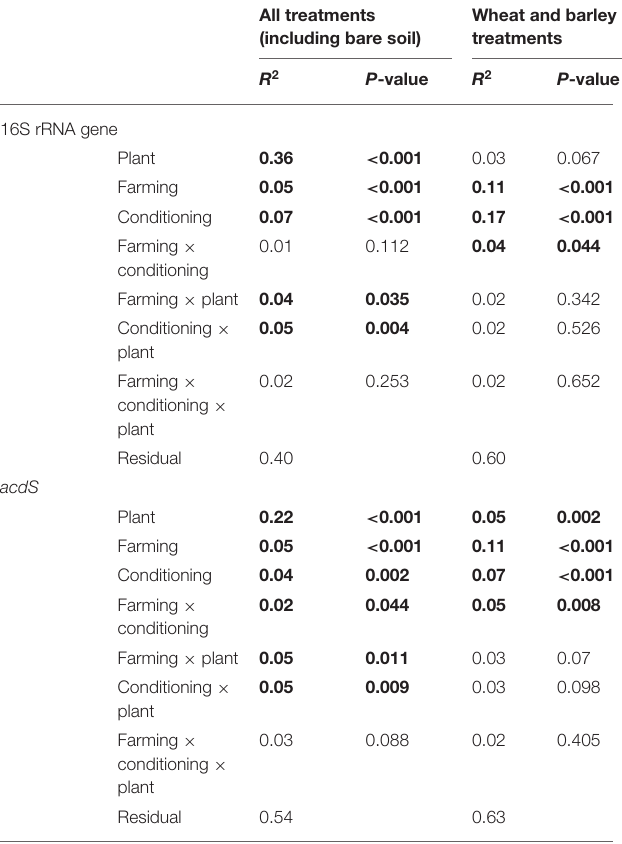
TABLE 1 | PERMANOVA of the 16S rRNA and acdS gene composition.